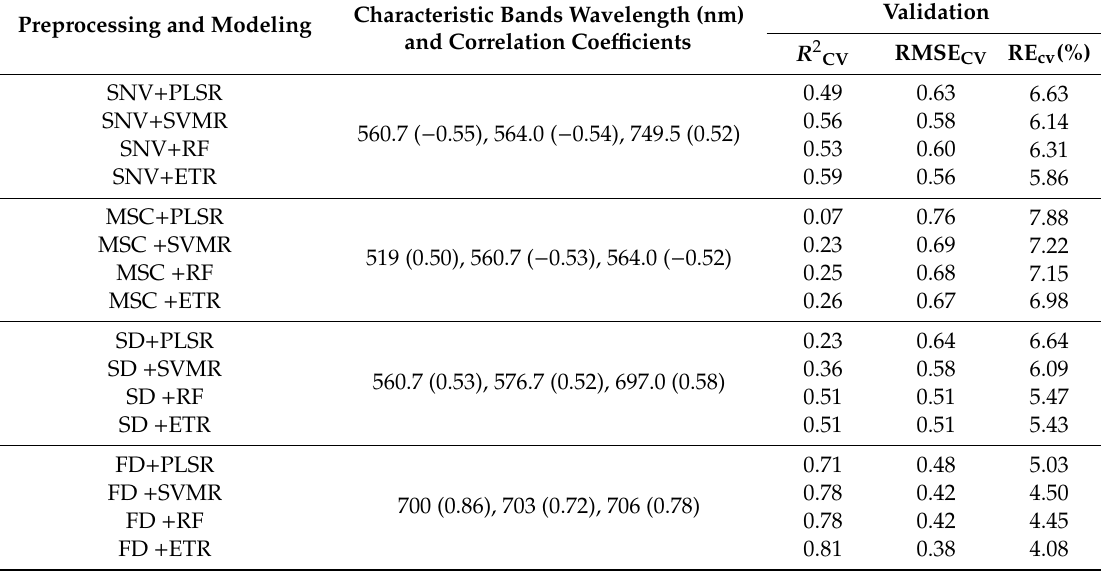
Table 2. Results of model regression based on the di ff erent preprocessing methods.